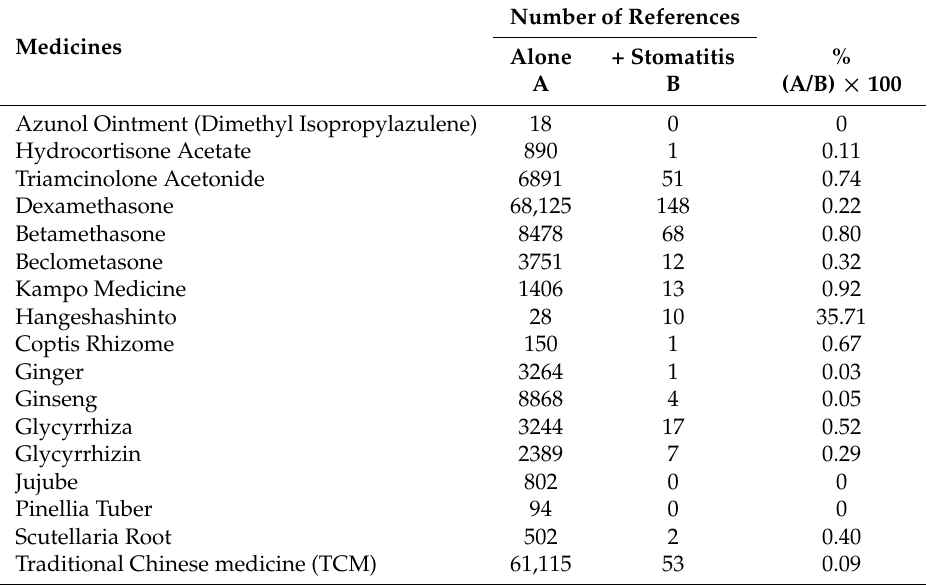
Table 3. Medicines used for treatment of stomatitis (data obtained from Pubmed on 16 January 2019).